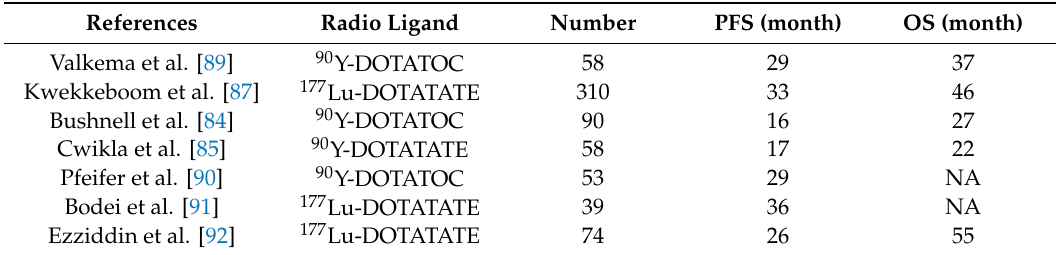
Table 3. Retrospective trials on neuroendocrine tumors (NETs) using peptide receptor radionuclide therapy (PRRT) [84,85,87,89–92]. PFS = progression-free survival; OS = overall